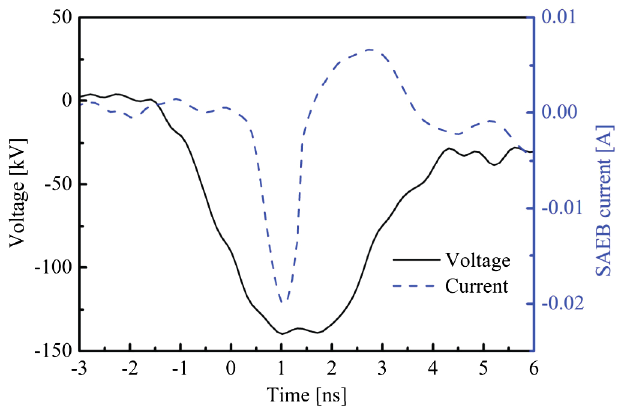
FIG. 4. Dependence of the voltage across the gap and SAEB current on SF 6 pressure (a) and SF 6 concentration in Kr-SF 6 (b) and N 2 -SF 6 (c) mixtures at atmospheric pressure. Interelectrode distance d ¼ 8 mm.